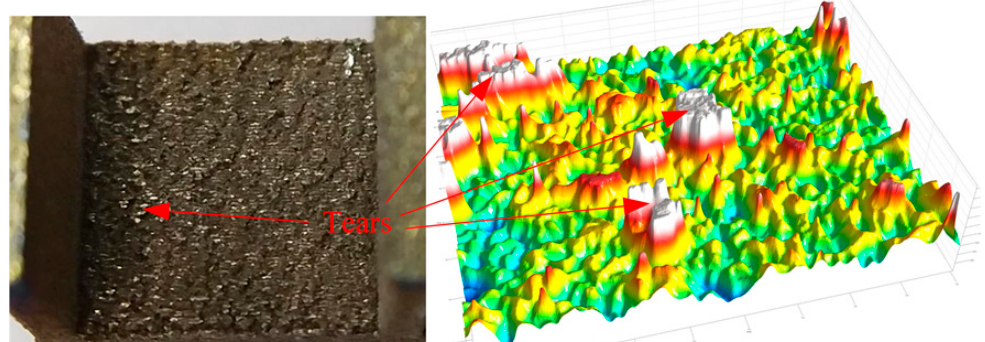
Figure 13. Morphology of the bottom surface of the overhang A in specimen 20.